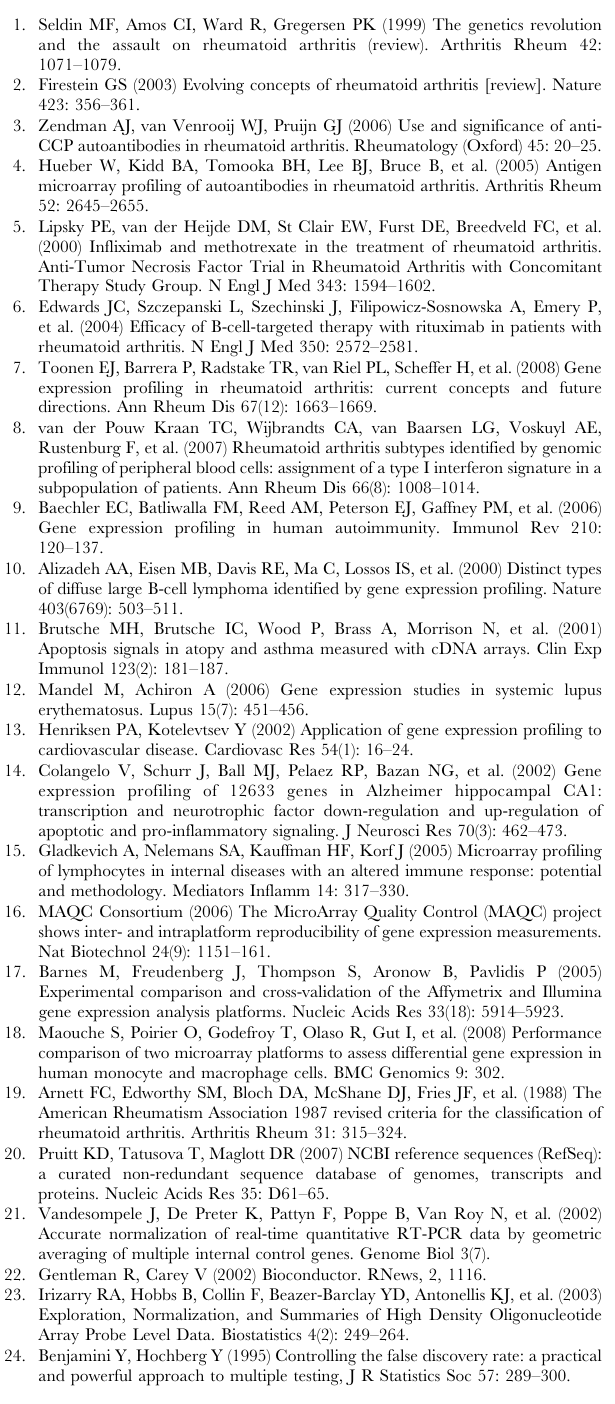
Table S3 List of 101 upregulated genes differentially expressed between RA patients and